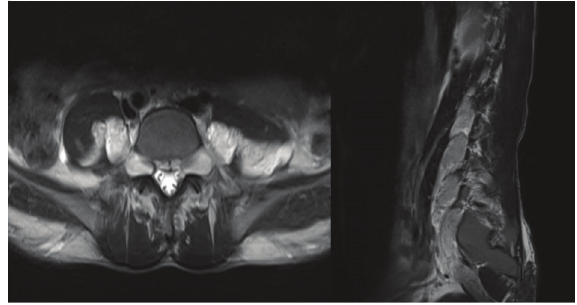
Figure 4: T2W MRI scan of the lumbar spine showing bilateral enlarged exit neural foramen along with extensive neurofibromas and bilateral plexiform